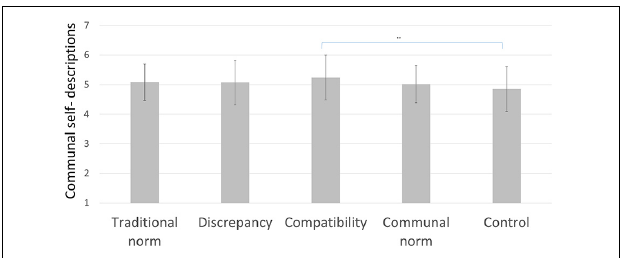
( M = 3.48, SD = 1.35), p < 0.001, d = 1.70, [1.49; 2.33]. Those in the communal norm condition indicated agentic traits as being less valued by their peers ( M = 3.48, SD = 1.35) compared to the discrepancy condition, p = 0.002, d = 0.50, [0.23; 1.07] and the